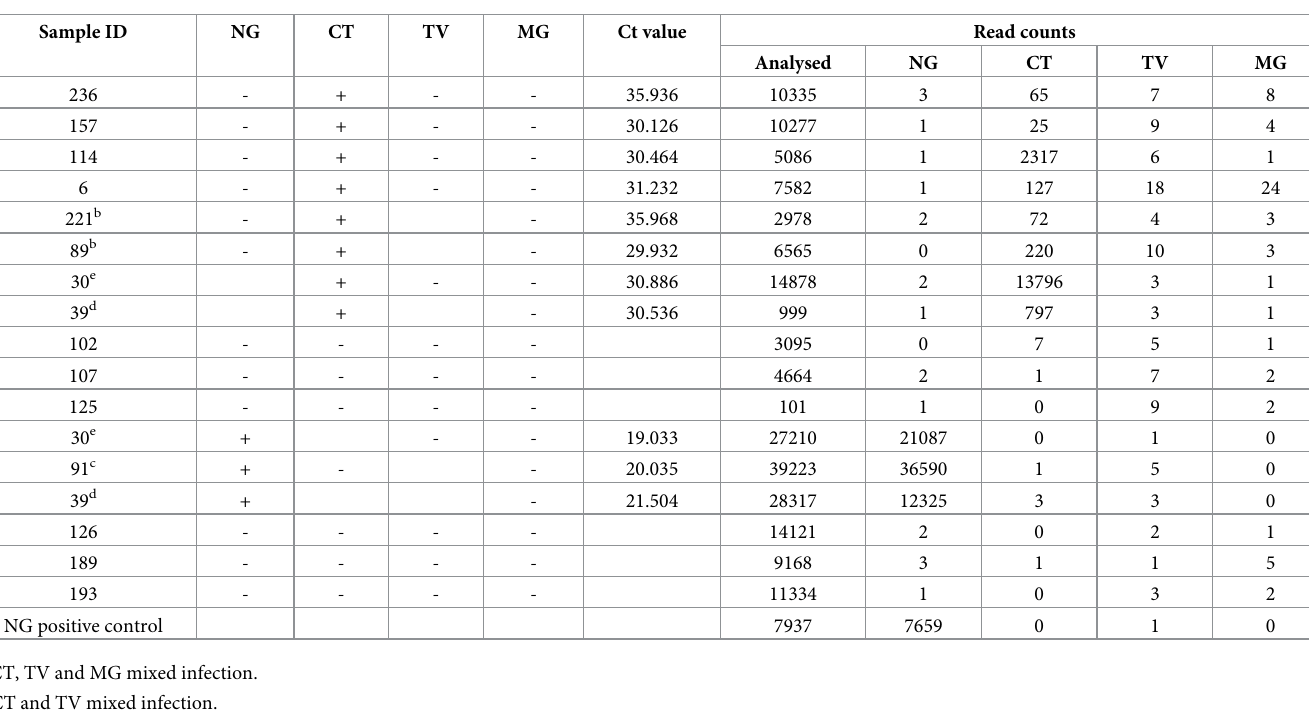
sequencing All 43 qPCR positives plus 12 negatives (3 for each pathogen) and an NG positive control were subjected to single gene tPCR nanopore sequencing in one barcoded sequencing library. A sequencing run of 10 hours produced 1,499,872 reads of which 1,127,703 (76%) reads passed QC, with total yield of 1.2 gigabases, average qscore 8.34 (S1 Fig) and average sequence length 816 bases. To identify MG, NG and CT, all reads (1,127,703) which passed QC were analyzed by WIMP, resulting in 810,683 (72%) classified reads of which 43,491 (5.4%) were non-bar- coded. For TV identification, Fastq Custom Alignment workflow produced 148,458/1,127,703 (13%) read alignments with TV ntr6 sequence of which 66,500 (5.9%) were non-barcoded. Targeted amplicon sequencing from clinical samples, as expected, still non-specifically pro- duced some reads from other microbial and/or host DNA in the sample. Among 810,683 clas- sified reads of the whole sequencing library, 560,601 (69%) mapped to the human genome. Details on the bacterial species that was mapped are shown in S1 Table. The ranges of classified reads mapped to the pathogens of interest are 0.5–95% (median 9.6%) for the CT positive sam- ples, 0–86.6% (median 48.5%) for the MG positive samples and 92.3–95% (median 94.7%) for the NG positive samples, while the range of analysed reads mapped to TV in the TV positive samples is 0–99.4% (median 0.1%). However, for STI pathogens, qPCR positive samples gener- ally yielded higher specific read counts than qPCR negative controls, all of the latter of which had fewer than 15 reads (Fig 1). Mean log read counts were higher in qPCR positive 10